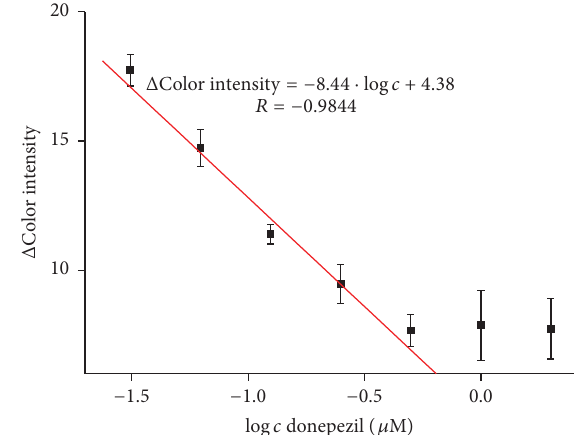
Figure 10: Validation of donepezil assay compared to standard Ellman’s assay. Error bars for smartphone assay represent standard error of the mean and for Ellman’s assay standard deviation for 𝑛 = 3.